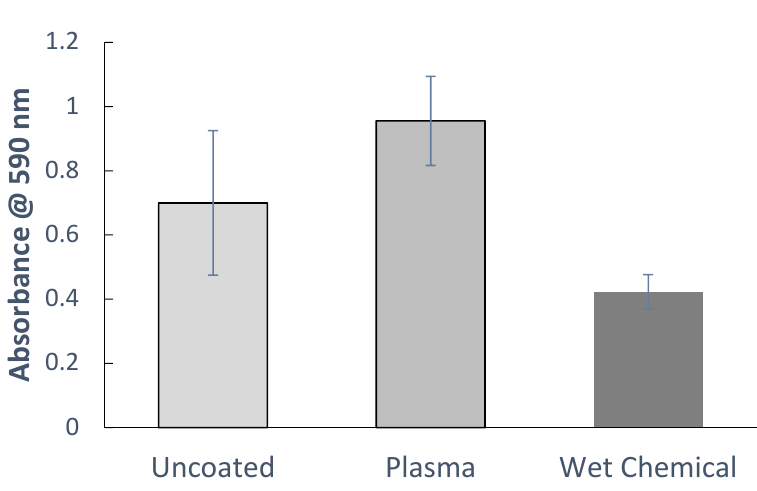
Figure 13. MTT assay at 24 h from HepG2 cells. Results are average of six readings.